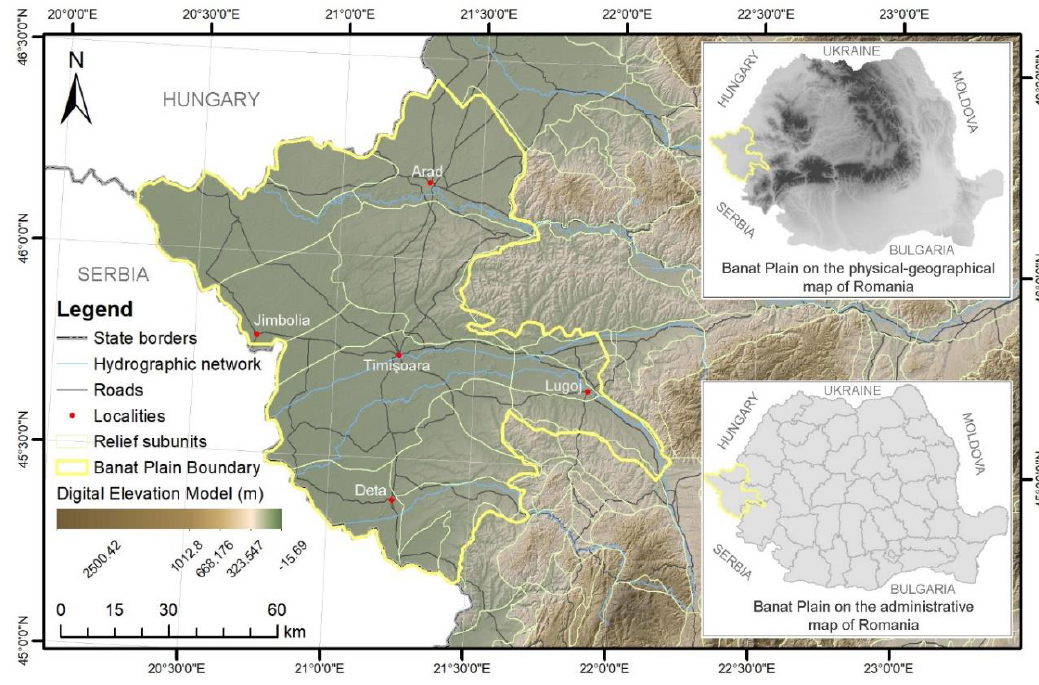
Figure 1. Study area, Banat Field [40,41].